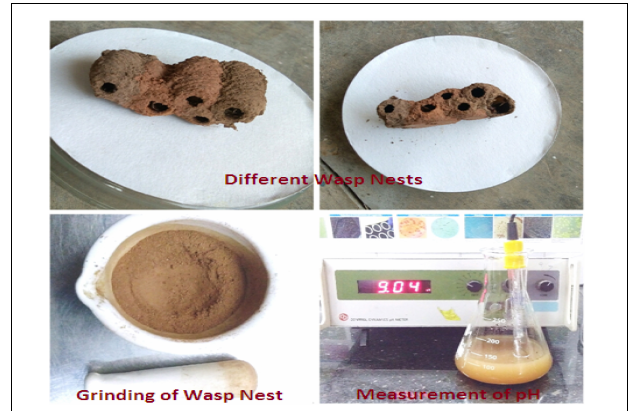
FIGURE 2 | Collection of wasp nest and grinding of soil and pH